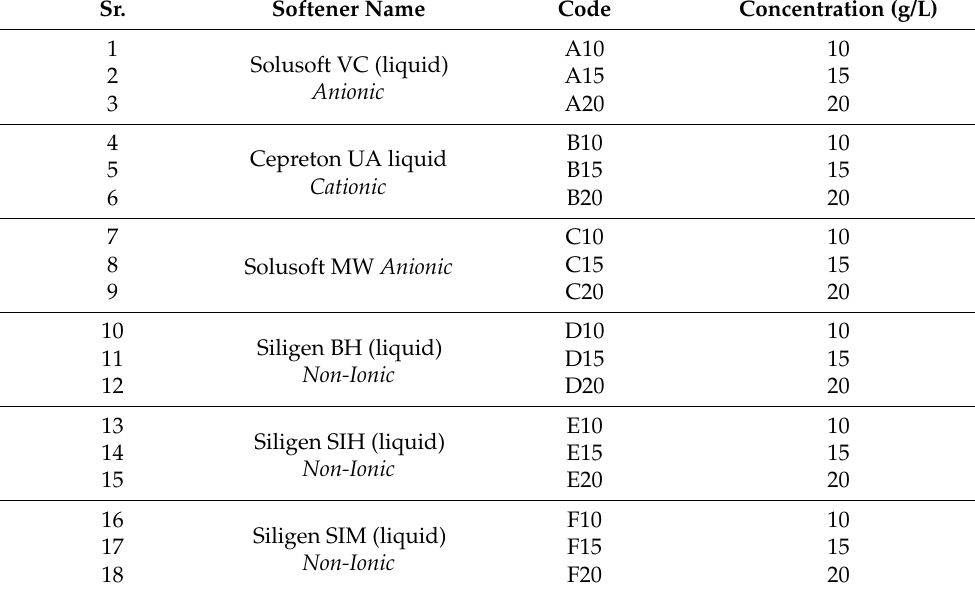
Table 1. Softeners names, codes, and